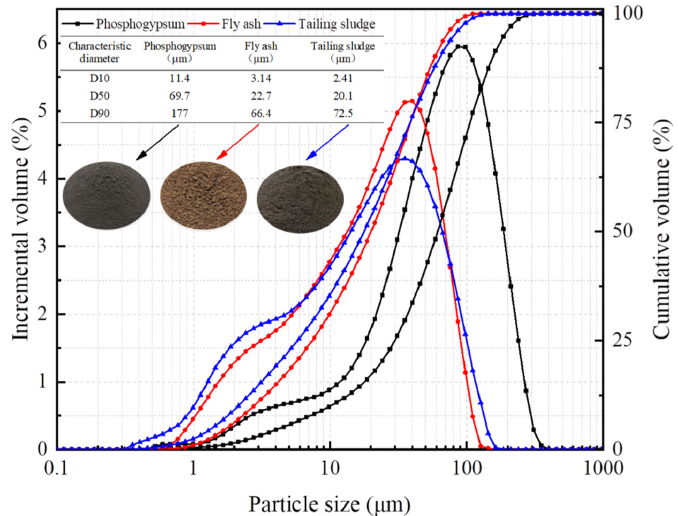
Figure 1. Particle size distribution of phosphogypsum, fly ash, and tailing sludge. Table 1. Particle size distribution of tailings.